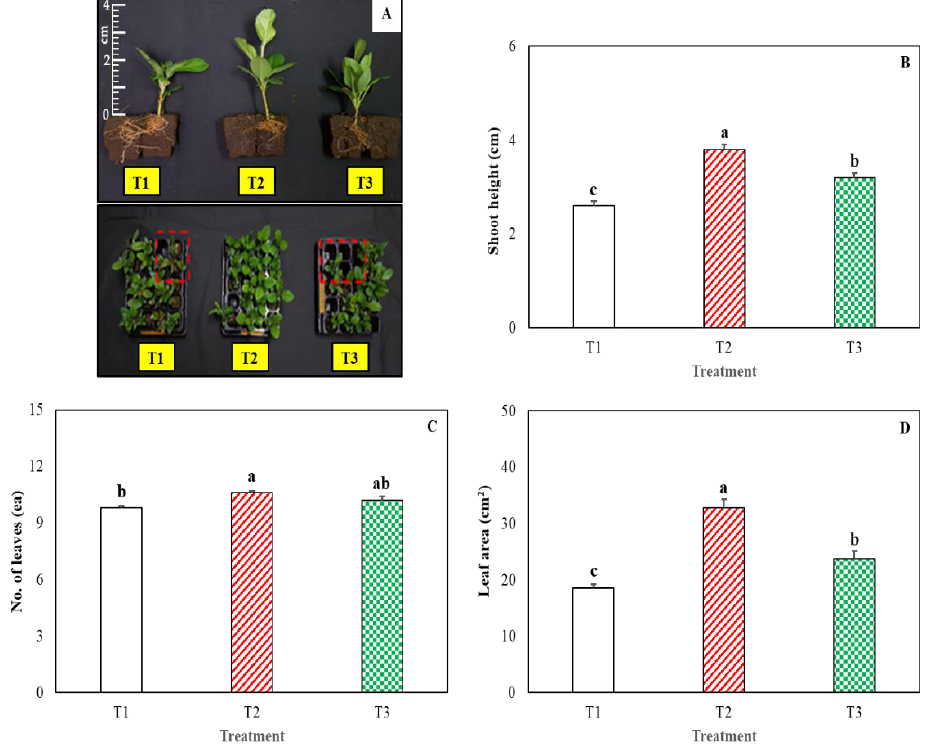
Figure 1. Effect of temperature treatment on the morphology of plants ( A ), shoot height ( B ), number of leaves ( C ) and leaf area ( D ) of apple seedlings at 20 days after treatment in a growth chamber. T1, T2 and T3 indicate day/night temperature 18/18 ◦ C, 23/18 ◦ C and 30/18 ◦ C, respectively. The lines above the bar represent the standard error of the mean (n = 5). Means above each bar followed by the same letters are not significantly different by Duncan’s multiple range test (DMRT) at p ≤ 0.05. Table 2. Effect of temperature on the growth and chlorophyll content of apple seedlings at 20 days after treatment in a growth chamber. T1, T2 and T3 indicate day/night temperature 18/18 ◦ C, 23/18 ◦ C and 30/18 ◦ C, respectively.